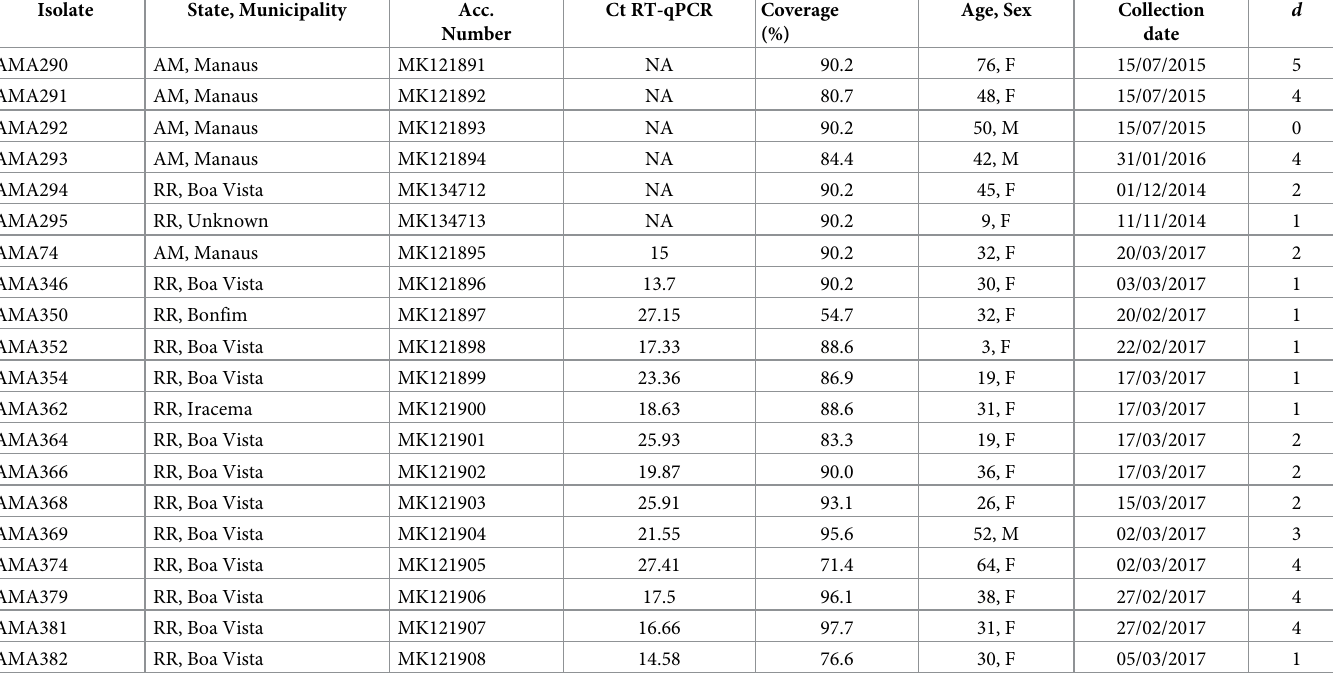
Table 1. Epidemiological data for virus isolates from Roraima (RR) and Amazonas (AM). CT = cycle threshold, d = days from onset of symptoms to sample collection. Corresponding sequencing statistics are available in S1 Table . Isolates were collected around 2.3 (range: 0–5) days after onset of symptoms. Acc. Number = GenBank accession